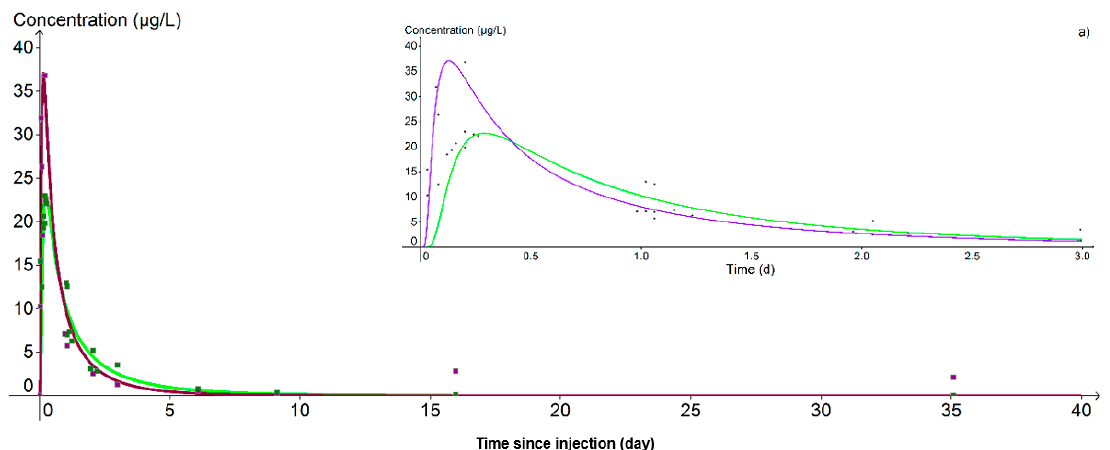
Figure 10. Evolution of uranine (green curve) and lithium (purple curve) concentrations at the nearest downstream piezometer (PZ2BIS). ( a ) Detail of the 3 first days. The peak at 148.1 µ g · L − 1 obtained with the lithium is not shown because it could not be simulated.